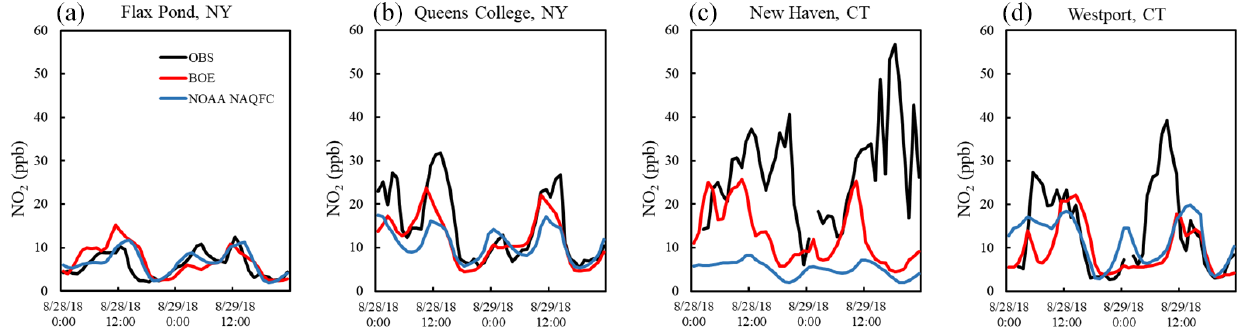
Figure 10. Variations of observed (OBS) and simulated surface NO 2 concentrations by the 3km BOE system (BOE) and the 12km NOAA NAQFC system (NOAA NAQFC) at (a) Flax Pond, NY; (b) Queens College, NY; (c) New Haven, CT; and (d) Westport, CT, sites during 28–29 August